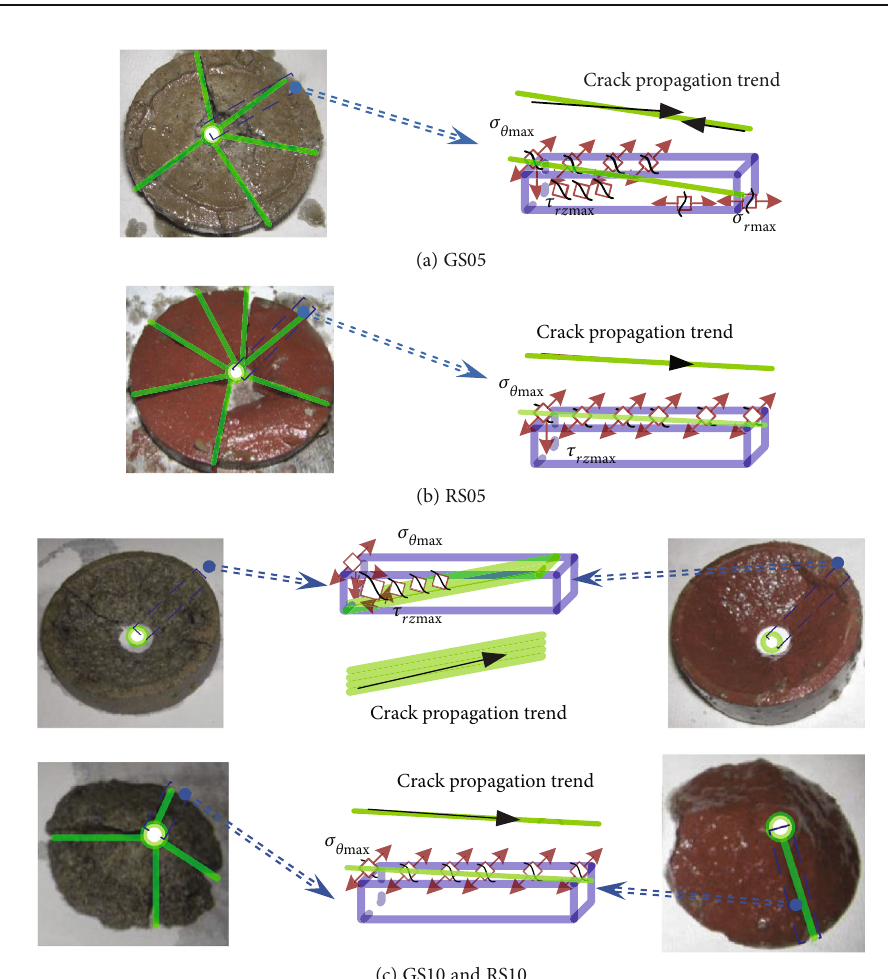
Figure 14: The mechanism of crack